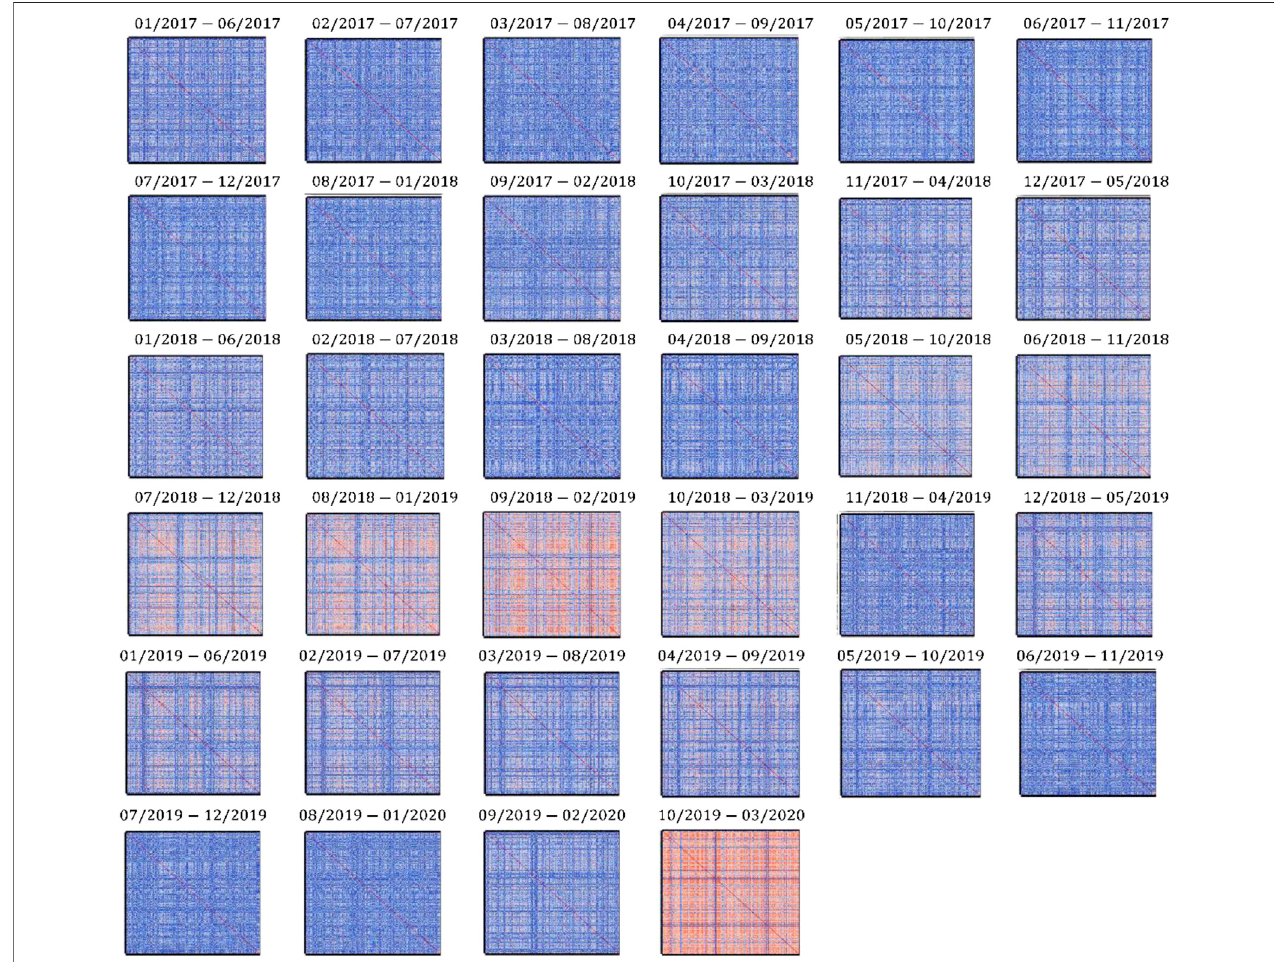
FIGURE 9 | The correlation matrices of TAIEX from Jan 2018 to Mar 2020.